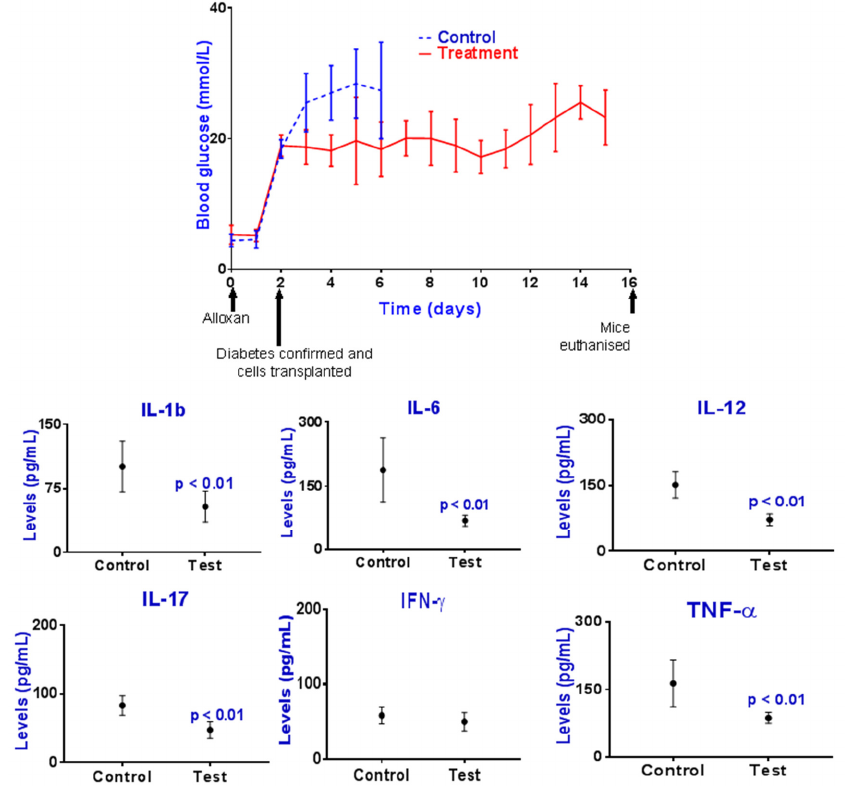
Figure 4. Postprandial blood glucose and plasma cytokines concentrations for control and test groups. Data are mean ±